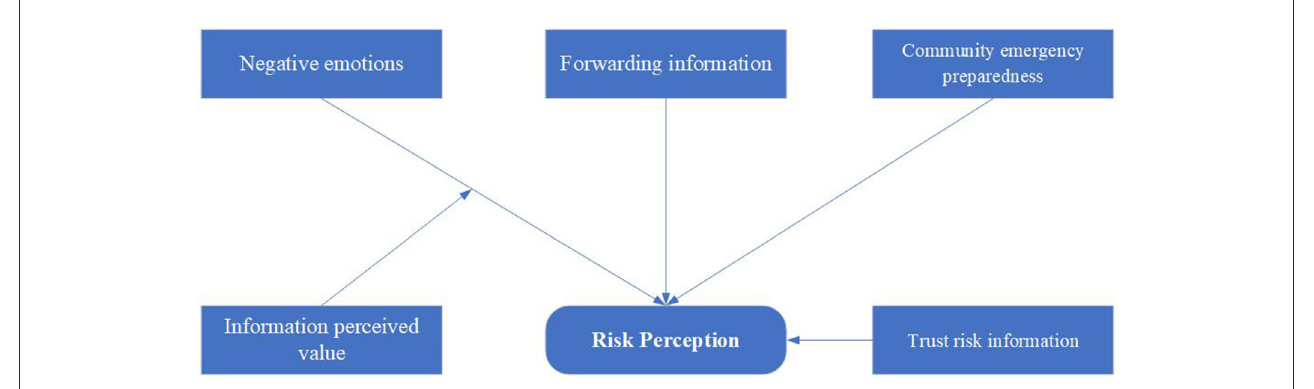
FIGURE1 Hypothesized model depicting factors influencing risk